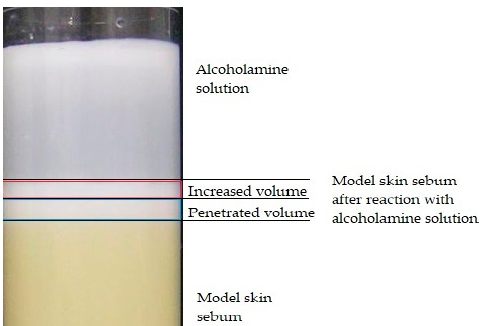
Figure 1. Measurement of sebum volume using the optical method and computer program for calculations. Alcoholamine reacts with the components of model skin sebum, e.g., stearic acid, and amine soap is formed. The reaction is manifested by the formation of a bright, reacted layer above the intact sebum layer. The resulting soap, by binding water, loosens the remaining sebum components of the sebum layer, unreacted with AMPD, facilitating their detachment and transfer to the solution. Both the penetrated volume and the increased volume of sebum are composed of the resulting soap and loosened sebum. Measurements were taken of the height of the sebum column that reacted with alcoholamine ― the etching of the sebum layer was ascribed as the penetration depth, and this description was applied consequently in the study ― and the height of the reaction products obtained (height of increase) beyond the initial level. On this basis, we calculated the volume of reacted sebum (penetrated volume) and the volume of sebum raised above the initial level (increased volume).